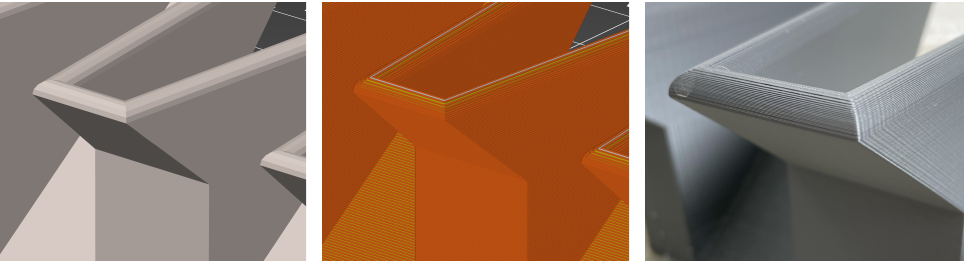
Figure 4. From digital data to final model, left : STL model, middle : sliced layer model, right : final